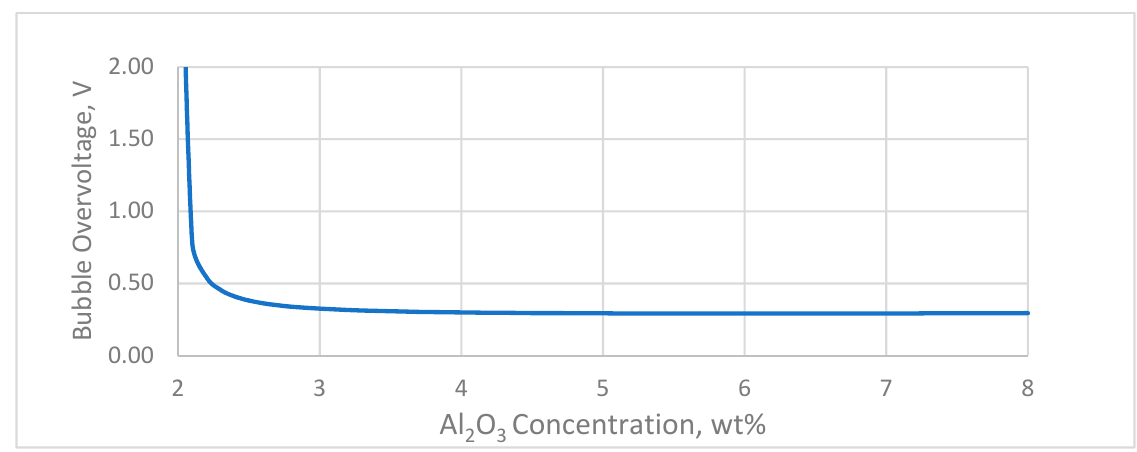
The voltage drop of the various cell elements depends on the specific design of each cell and the cell current. However, approximate values of the electrical resistance of the cell elements could be considered according to Grjotheim and Welch (1988) [2], which are (i) over the whole anode array 0.35 V; (ii) over the cathode 0.35 V, and (ii) external bushbar 0.30 V, corresponding to a total voltage drop of up to 1 V. However, in modern cells this could be as high as 0.70 to 0.80 V (Figure 8).